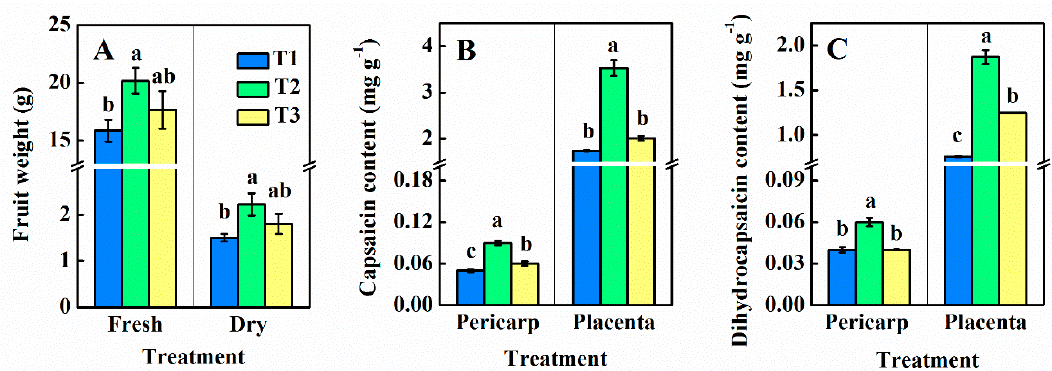
Figure 5. Fruit weight ( A ), capsaicin ( B ), and dihydrocapsaicin ( C ) contents in pepper pericarp and placenta at different NH 4+ :NO 3 − ratios. T1, NH 4+ :NO 3 − = 0:100; T2, NH 4+ :NO 3 − = 25:75; T3, NH 4+ :NO 3 − = 50:50. Vertical bars represent the mean ± SE ( n = 3) and different letters denote significant differences ( p < 0.05).